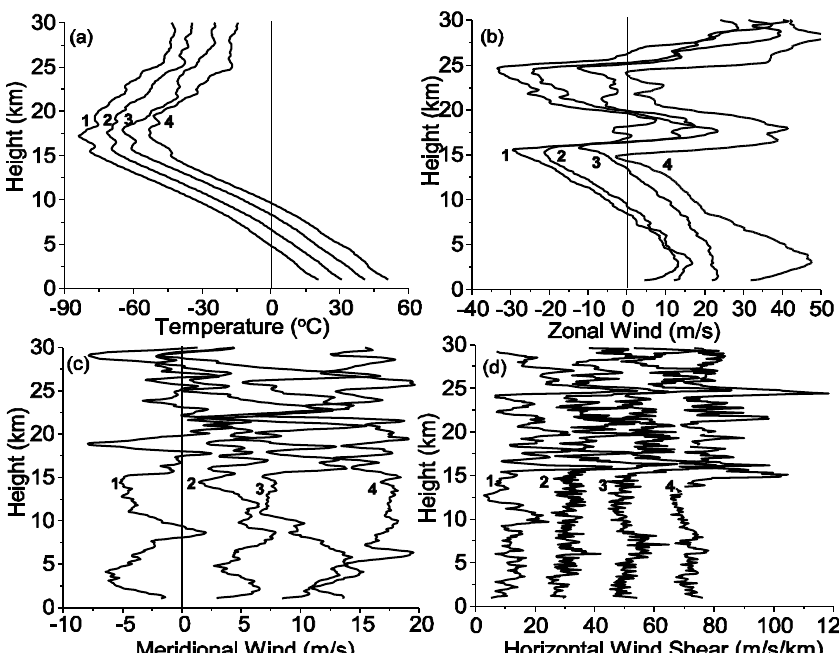
Fig. 2. Vertical profiles of (a) temperature ( ◦ C), (b) zonal wind, (c) meridional wind, (d) and horizontal wind shear on four different Figure 2. Vertical profiles of (a) Temperature ( o C), (b) Zonal wind, (c) Meridional wind, (d) and observation days (numerals 1, 2, 3, and 4 on profiles denote 30 November, 6 December, 9 December, and 18 December 2005, respectively). Horizontal wind shear on four different observation days (numerals 1, 2, 3, and 4 on profiles denotes 30 A constant number (10 in panels a and b , 5 in panel c , and 20 in panel d ) is added to avoid overlapping in all the panels. The average profiles Nov, 06 Dec, 09 Dec, and on 18 Dec 05, respectively). A constant number (10 in panels ‘a’ and ‘b’, 5 in were computed using 17 profiles for 6 December, and 19 profiles for the other three days. panel ‘c’, and 20 in panel ‘d’) is added to avoid overlapping in all the panels. The average profiles were computed using 17 profiles on 06 Dec and 19 profiles on the other three days. Table 1. Details of wind shear on all four days of